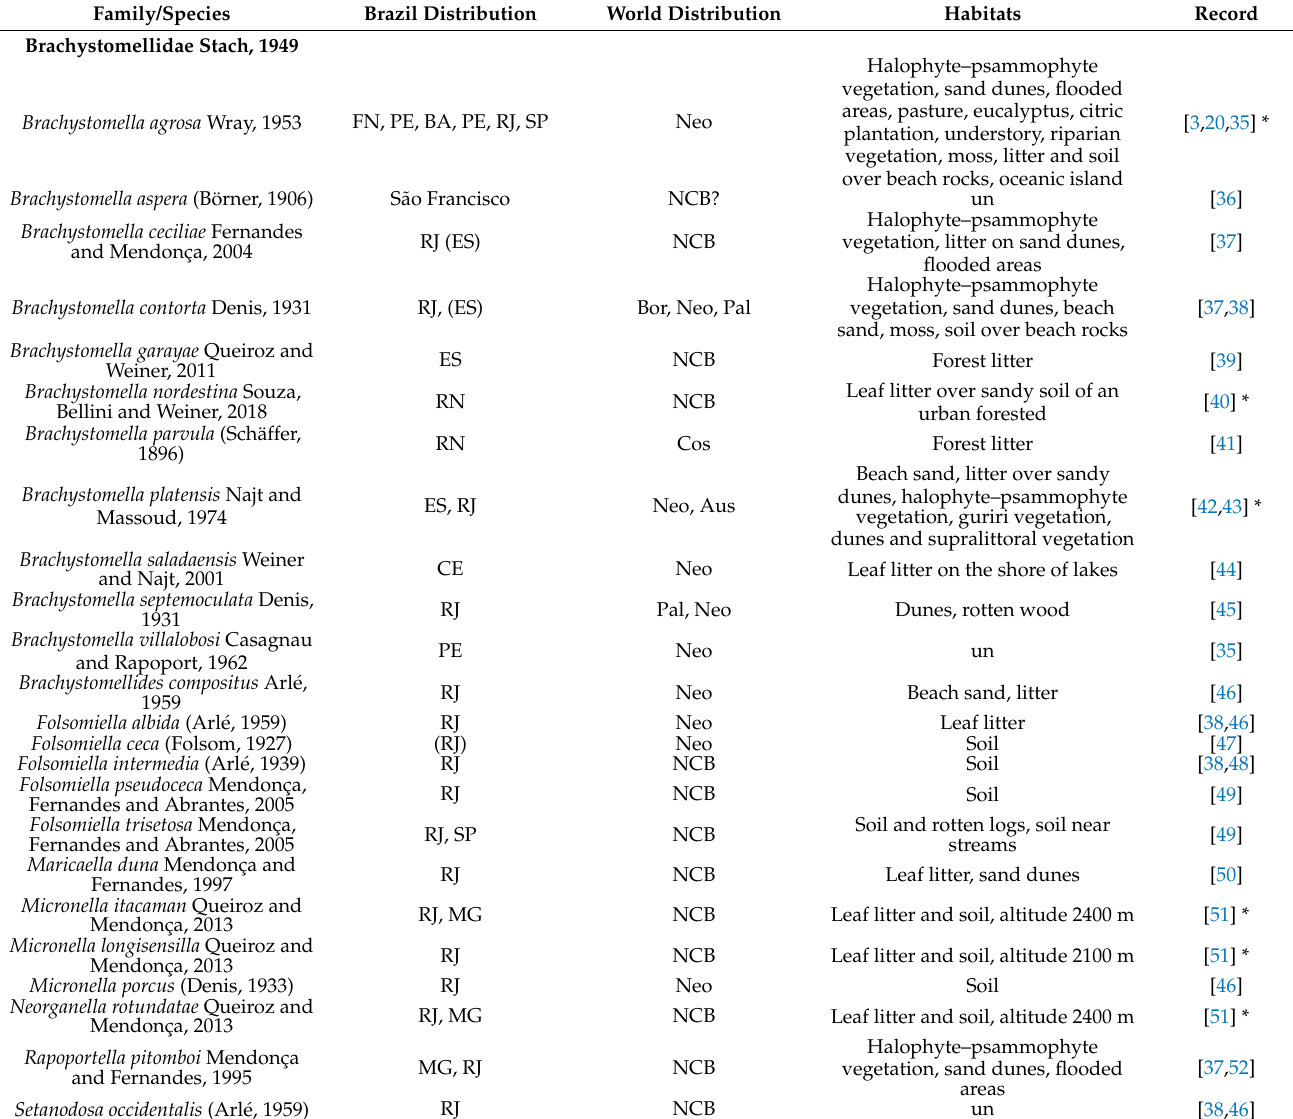
Table 11. Species of Poduromorpha recorded from Brazilian states and oceanic islands–updated from [2]. *—New record after [2]. In parentheses, information obtained from non-original reference. “?” following state abbreviation—questionable state record. “un”—unspecified or unknown Brazilian collection habitats. World distribution—see Methods/Species list of Brazilian Poduromorpha. “?” following the distribution abbreviation—questionable distribution record. Habitat— representative type of habitat for the species. “un”—unspecified or unknown habitat (Brazilian distribution, locality abbreviations refer to Brazilian states and Insular locality as listed in Table 1). Family names in bold. Family/Species Brazil Distribution World